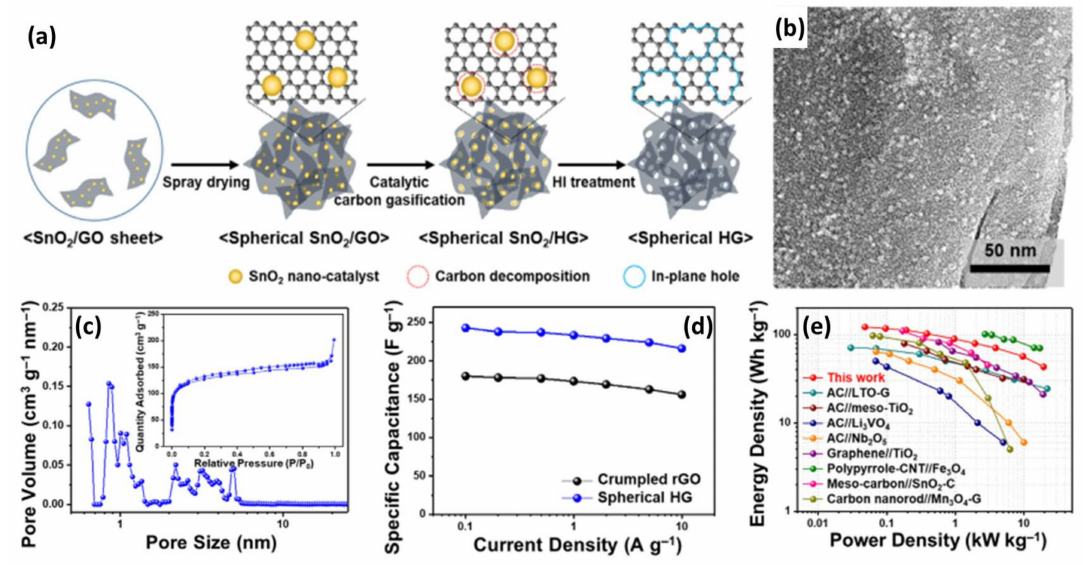
Figure 6. ( a ) Schematic of spherical HG preparation using catalytic carbon gasification; ( b ) TEM image and ( c ) N 2 adsorption/desorption isotherm (inset) and pore size distribution of spherical HG; ( d ) Rate capabilities for spherical HG and crumpled rGO; ( e ) Ragone plots for the LICs composed of spherical HG and spherical LTO/HG composite. (Reprinted with permission from Ref. [104]. Copyright 2019